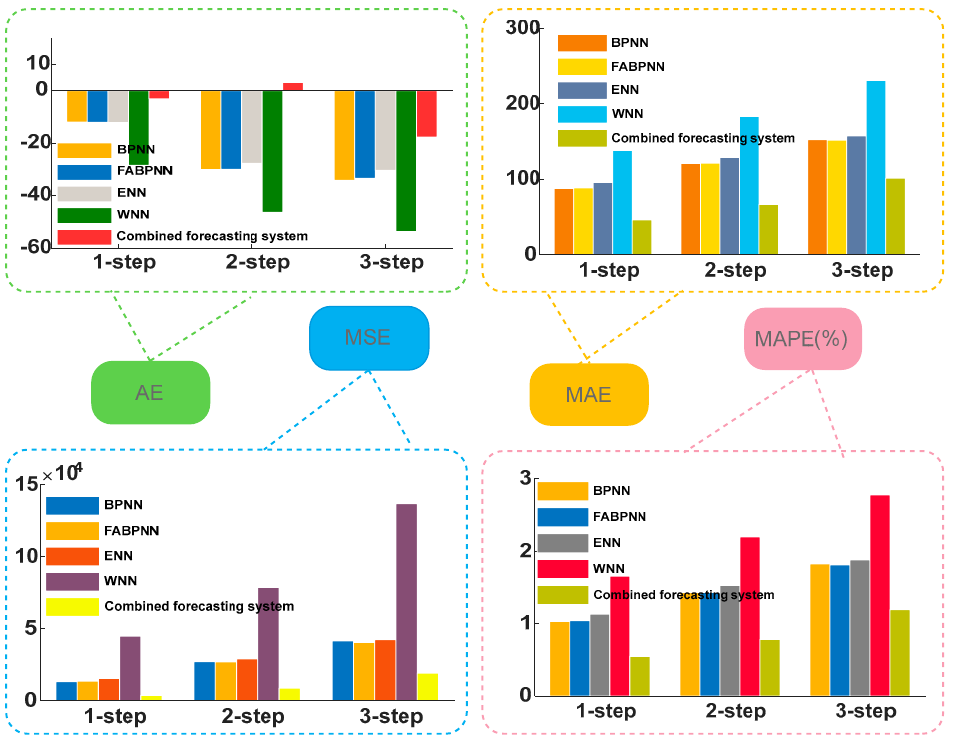
Figure 4. The results of AE, MAE, MSE and MAPE for February.